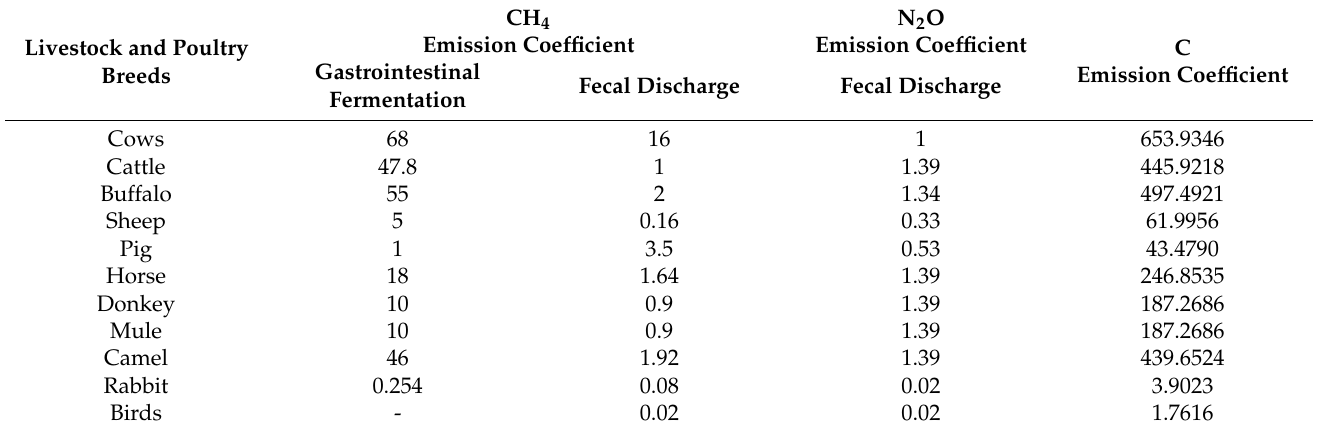
Table A3. Carbon emission coefficients of various livestock and poultry breeds. Unit: kg · head − 1 · a − 1